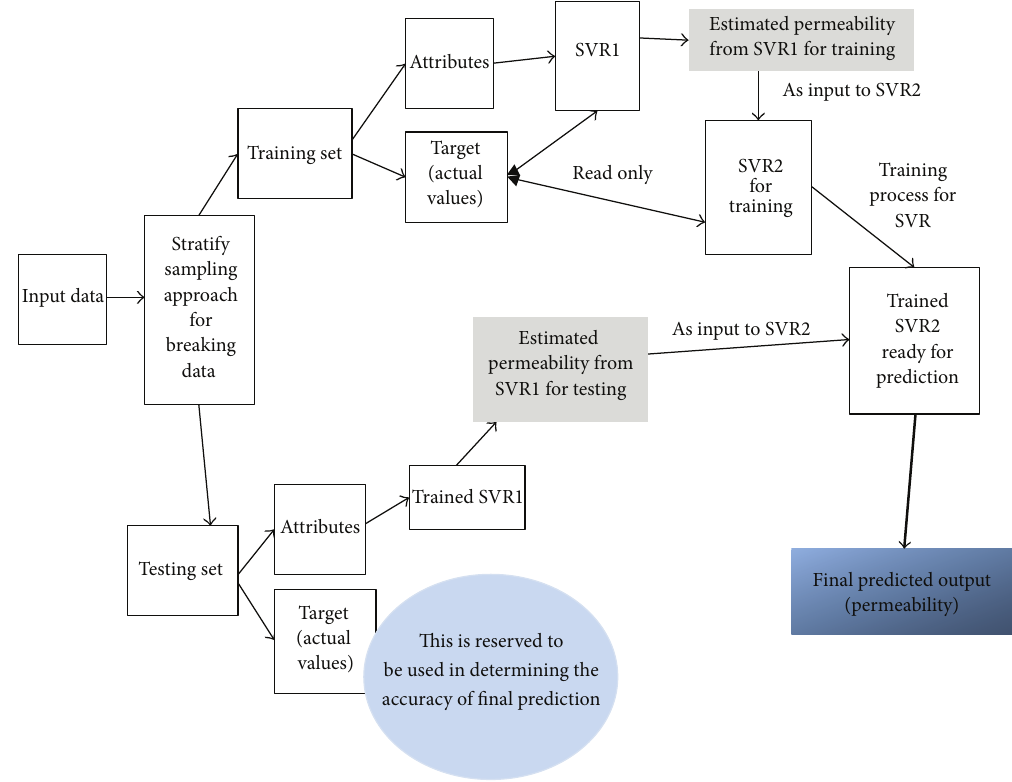
Figure 2: Data flow diagram of the proposed hybrid model